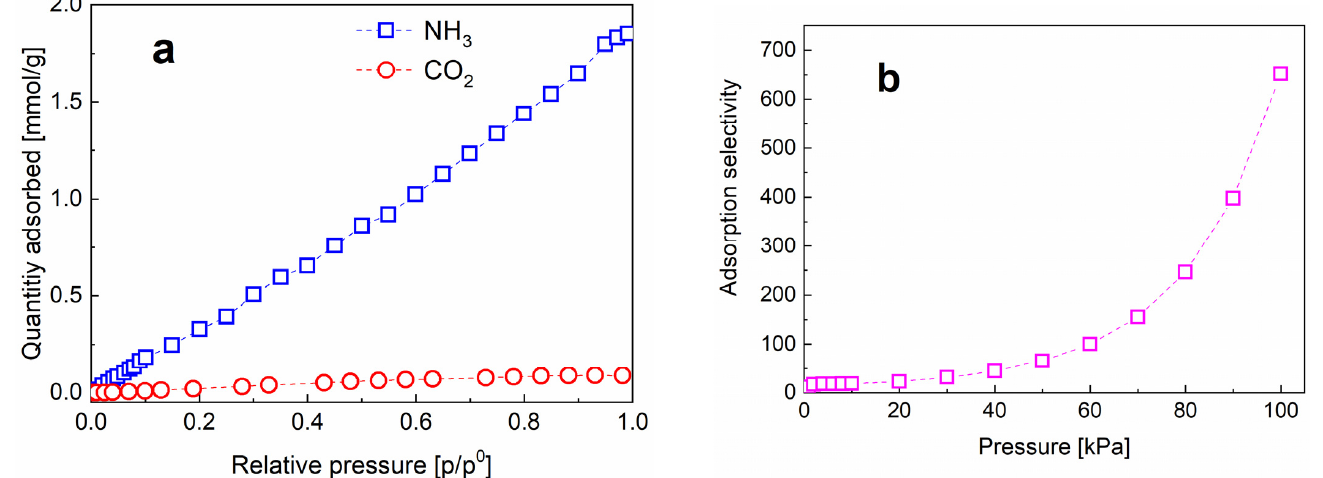
Figure 12. ( a ) The adsorptive performance toward two gases of NH 3 and CO 2 and ( b ) the adsorption selectivity of NH 3 /CO 2 .